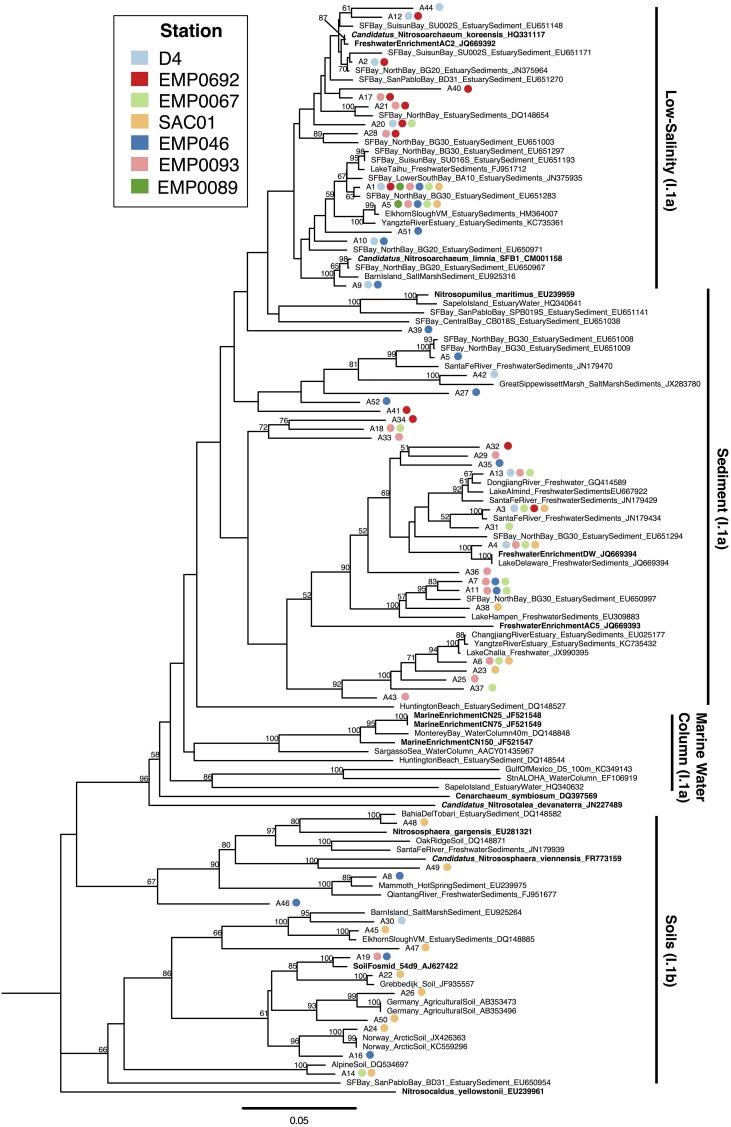
Neighbor joining tree of AOA amoA OTUs (≥95% similarity) from the Delta. Colored points next to each OTU indicate the composition of the OTU by station. Values at nodes indicate bootstrap support ≥50% (1000 neighbor-joining bootstrap replicates). Reference sequences from named organisms are indicated in bold. Clades referred to in the text are marked to the right of the tree.